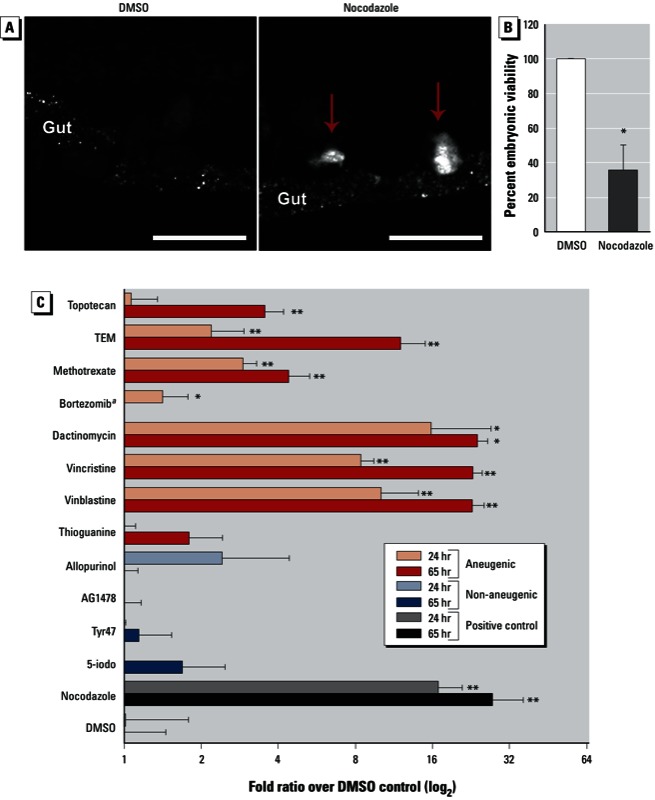
Chemical induction of aneuploidy in C. elegans. (A) Pxol-1::GFP worms were exposed to 100 µm nocodazole or 0.1% DMSO (control) for 24 hr. Two GFP+ embryos are visible within the nocodazole-treated worm’s uterus (arrows) adjacent to the autofluorescence emanating from the gut; bar = 50 µm. (B) Embryonic viability (mean percent ± SE) after either DMSO or nocodazole exposure. (C) Chemotherapeutic screen; the worms were exposed for 24 hr or 65 hr to 100 µM of each compound. The number of GFP+ embryos per worm was recorded, corrected for the average number of embryos found in each worm, and expressed as the log fold ratio over DMSO (mean percent ± SE; two-tailed Mann–Whitney U test, 95% CI, chosen over ANOVA with post-test correction to test for significant differences for each compound over DMSO because of high differences in sample variance). Each chemical exposure was performed six times.
aLethal at 65 hr. *p ≤ 0.05, and **p ≤ 0.01, by two-tailed Mann–Whitney U test, 95% CI.